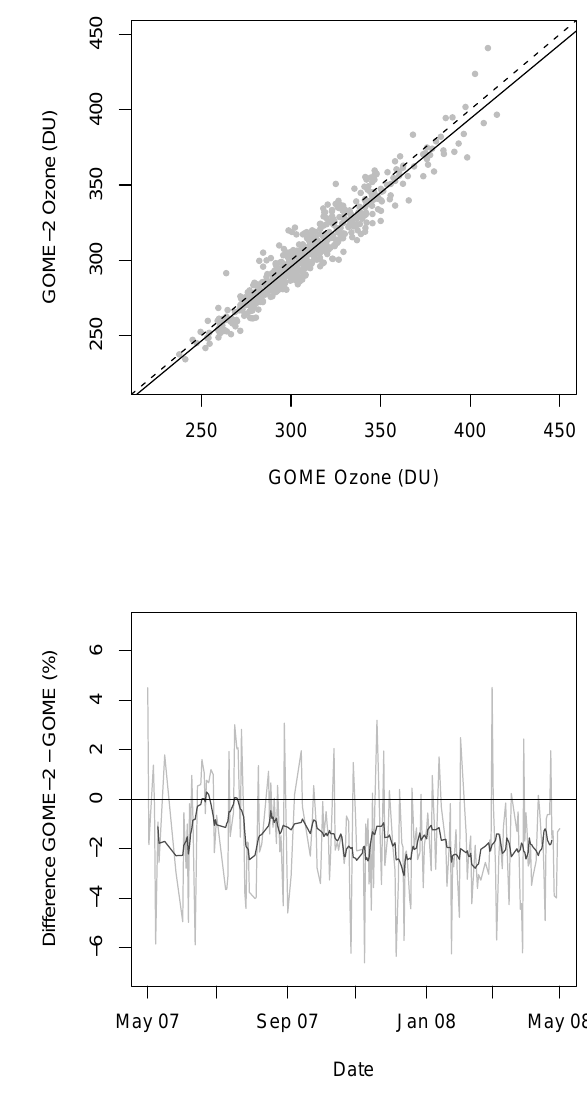
Fig. 6. Correlation between GOME/ERS-2 and GOME-2/MetOp total ozone data for the “Iberian Peninsula” dataset (top panel); the regression line (solid line) and unit slope (dashed line) show the good agreement. Seasonal variation (low panel) of the daily rela- tive difference between GOME/ERS-2 and GOME-2/MetOp total ozone data (grey line), and the corresponding running mean over ten days (dark grey